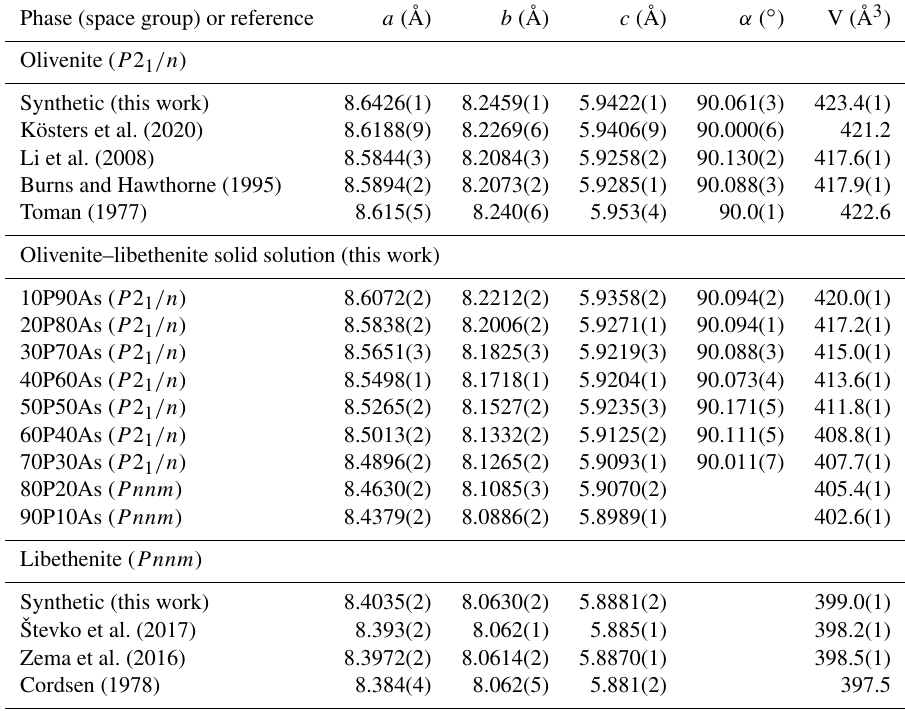
Table 2. Unit-cell parameters for the synthetic phases of the olivenite group, used in this work, compared to values from studies on natural material. The data from this work come from full-profile refinements of powder X-ray diffraction